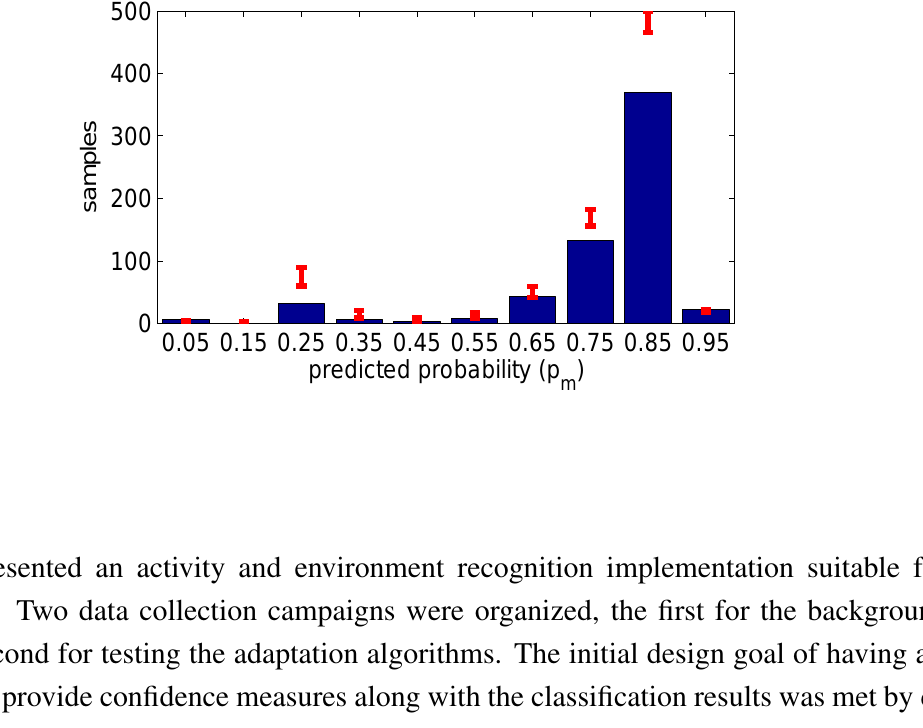
and 95% limits m